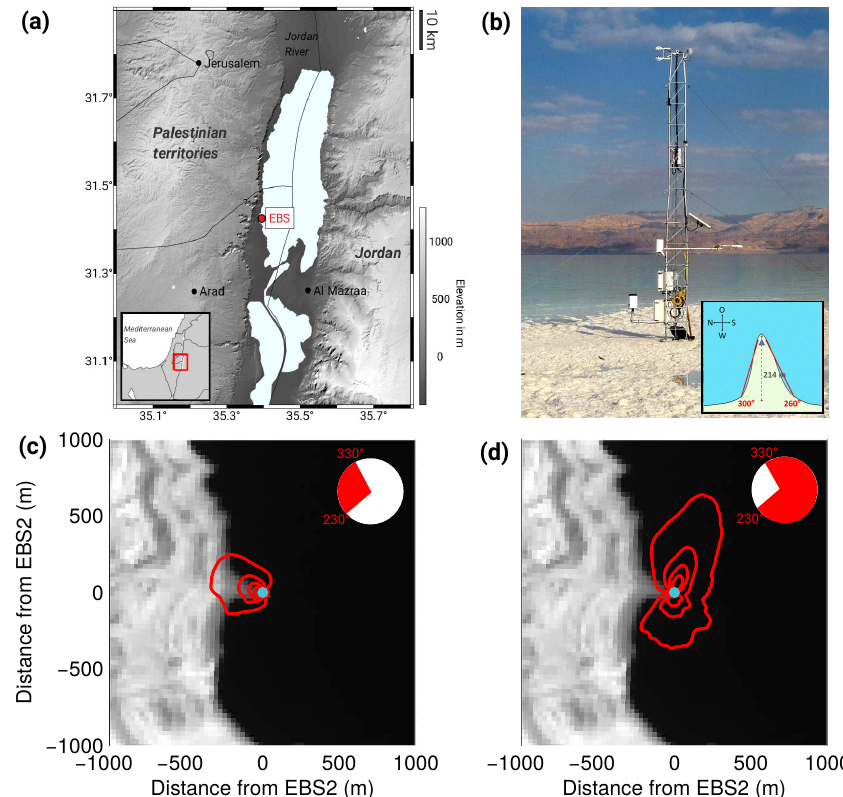
Figure 1. Map of the research area and location of the measurement site (a) ; image of the measurement site and sketch of the headland (inlet) (b) ; Landsat 8 images of the headland with location of the EBS (blue dot); and with the results of the footprint analysis (c, d) . Contour lines (from inside to outside) represent 20, 40, 60, and 80% of the flux footprint area calculated with the footprint model of Kljun et al. (2015) for offshore wind conditions with wind direction between 230 and 330 ◦ (c) and for the other wind directions (d) . Satellite data were provided by the US Geological